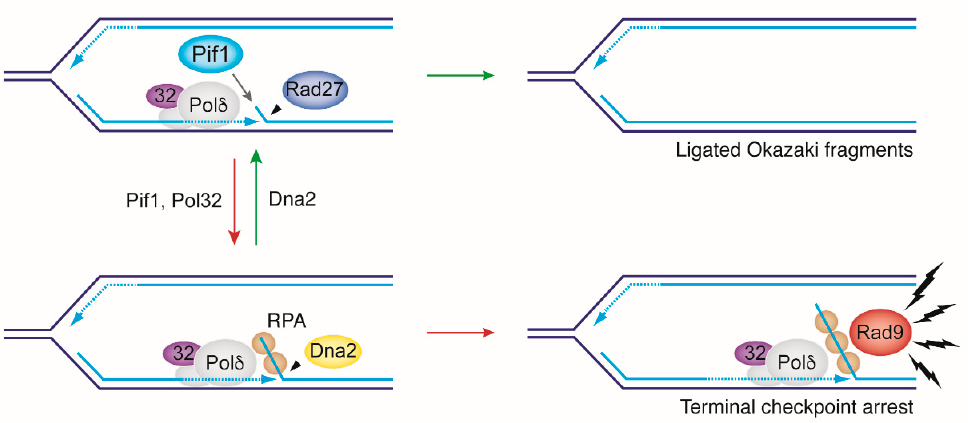
Figure 2. Model for an essential role of Dna2 in OFP. During DNA replication, Pol ε (not shown) synthesizes the leading strand in a continuous fashion while Pol δ synthesizes the lagging strand discontinuously in the form of Okazaki fragments. Limited strand-displacement DNA synthesis by Pol δ and instantaneous cleavage by Rad27 ensures the RNA/initiator DNA primer at the 5 ′ -end of each Okazaki fragment is removed through nick translation (iterative cycles of ~1 nt-flap generation and removal). DNA ligase I seals the final nick to establish the continuity of the lagging strand. The Pol32 subunit of Pol δ and the actions of the Pif1 helicase stimulate the strand-displacement activity of Pol δ , potentially leading to 5 ′ -flaps > ~30 nt, which become refractory to Rad27 by association with ssDNA-binding protein RPA. This creates an essential requirement for Dna2, which, unlike Rad27, is able to cleave RPA-covered flaps. In the absence of Dna2, RPA-covered flaps may accu- mulate and activate the DNA damage checkpoint in a Rad9-dependent manner, leading to a persis- tent cell-cycle arrest and, ultimately, cell death.